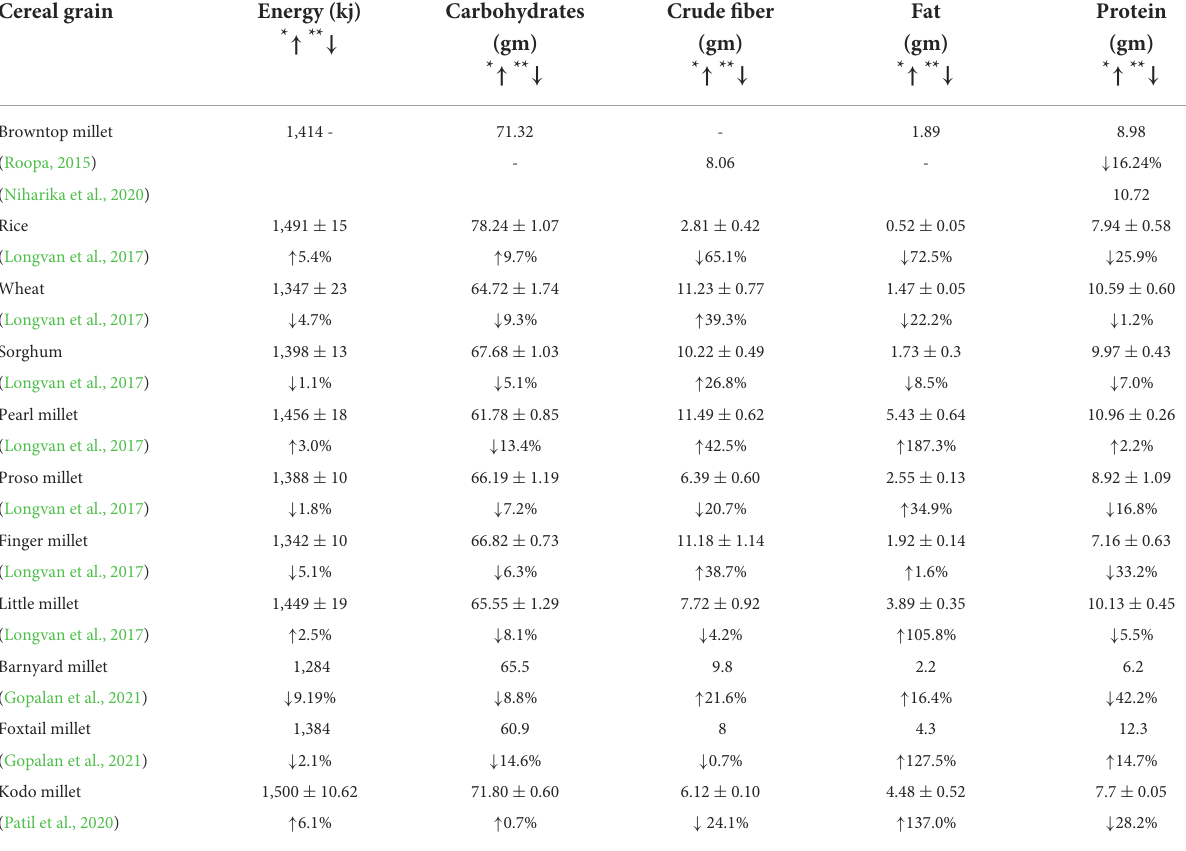
TABLE 3 Energy and macro-nutrient content of different millets and staple cereals compared with the browntop millet (in percent). Cereal